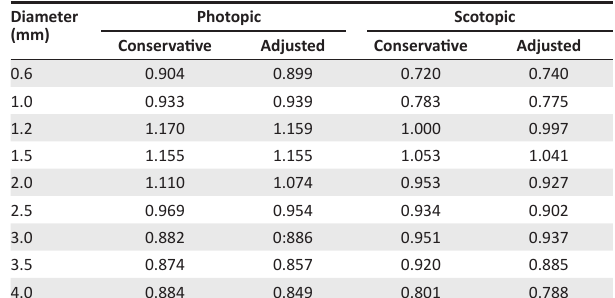
TABLE 7: Pinhole fitness